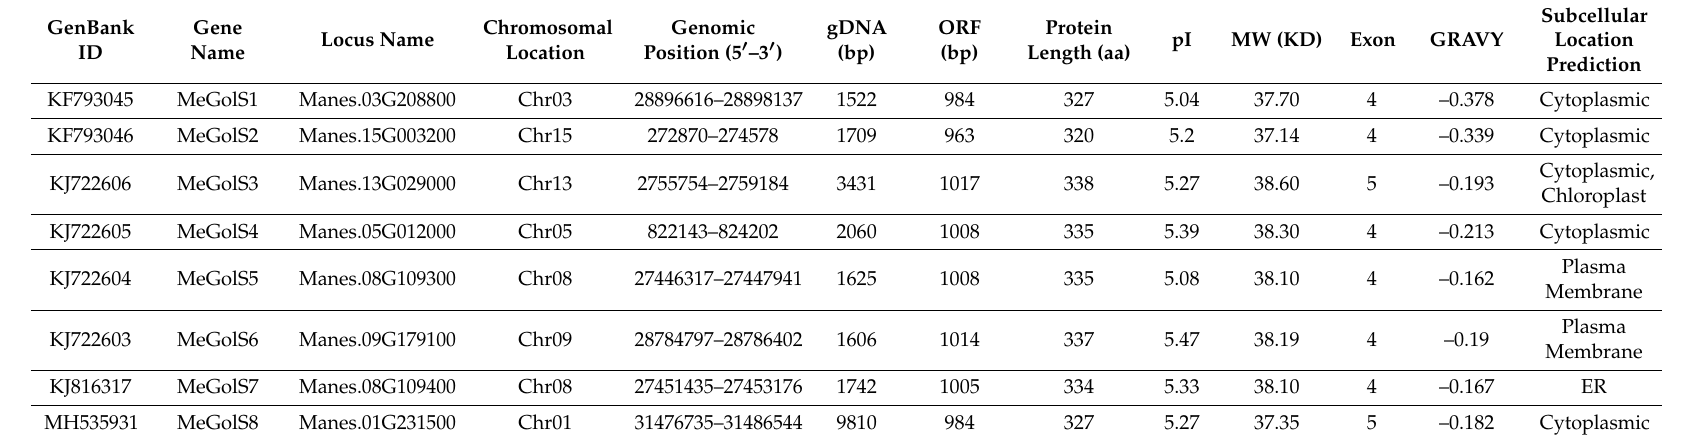
Table 1. Information of 8